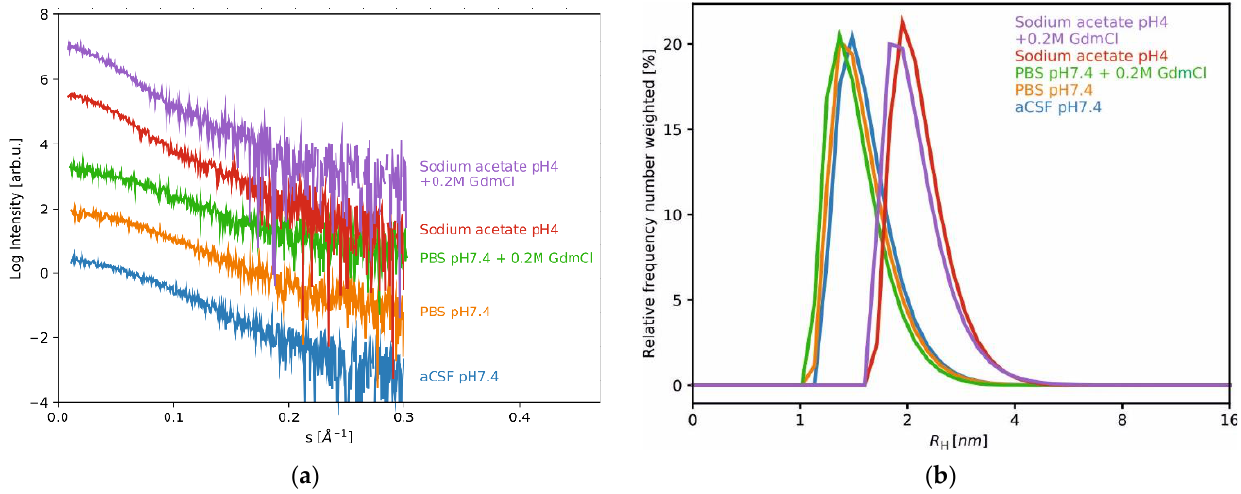
Figure 4. SAXS and DLS data collected for human cystatin C in mild denaturing conditions and aCSF: ( a ) SAXS data recorded for HCC at pH 4 and pH 7.4 and in the presence of 0.2 M GdmCl; ( b ) particle size distribution of human cystatin C (HCC), with the effect of 0.2 M GdmCl.